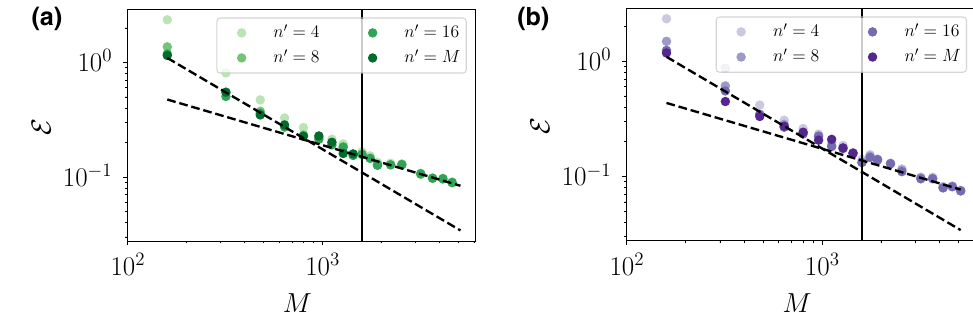
FIG. 10. The error scaling as a function of M , (a) for Pauli shadows and (b) for Haar shadows, showing the scaling of the average statistical error E as a function of the number of measurements M for the functional ˜ X ( n different values of n (cid:13) . The black line marks the value of M up to which we can simulate ˜ X ( M ) √ different error scalings ∝ 1 / M and 1 / M